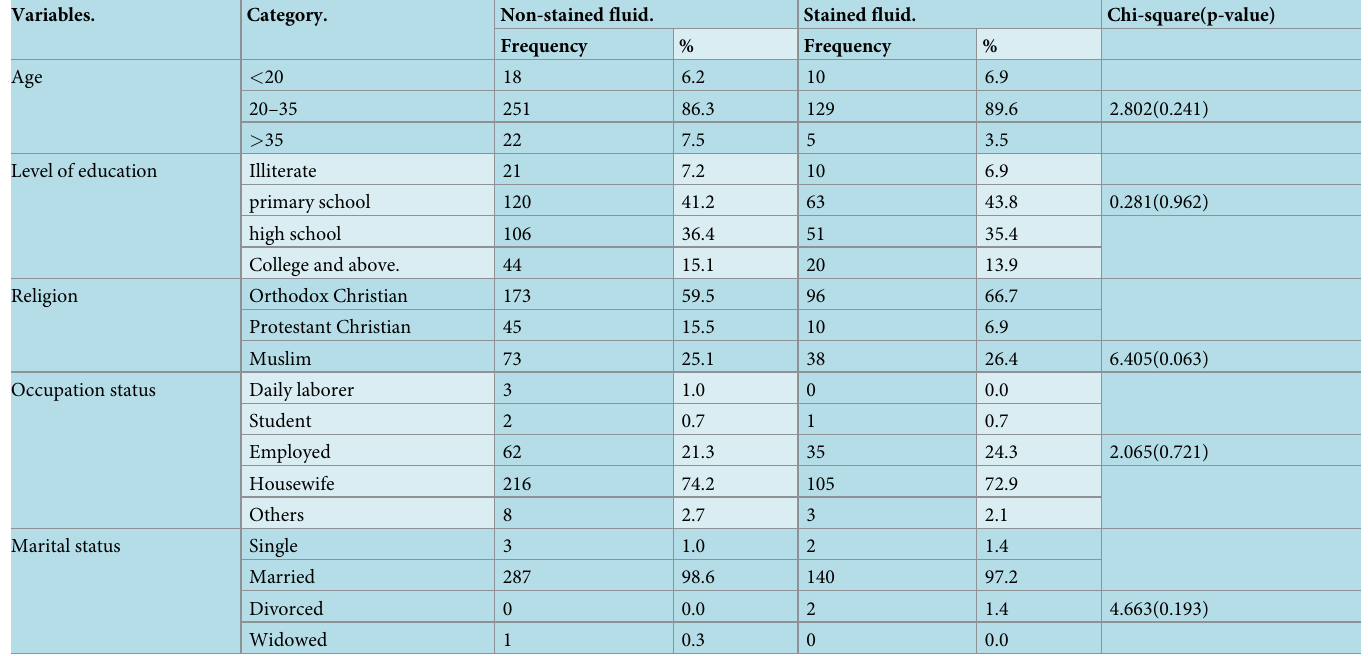
Table 1. Sociodemographic characteristics of laboring mothers at SPHMMC from July 1 to December 30, 2018. Variables.